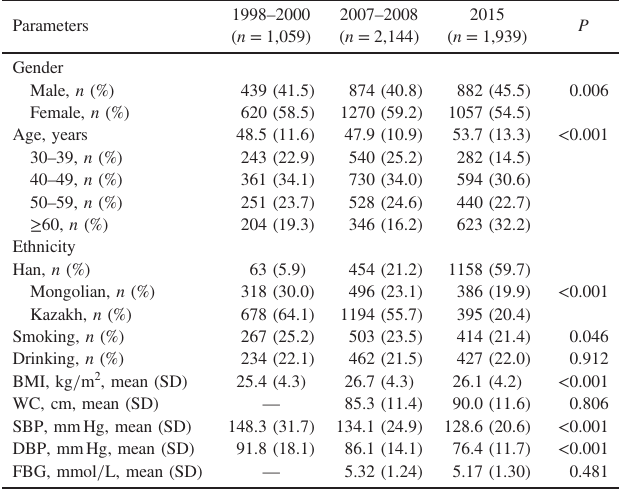
BMI, body mass index; DBP, diastolic blood pressure; FBG, fasting blood glucose; SBP, systolic blood pressure; SD, standard deviation; WC, waist